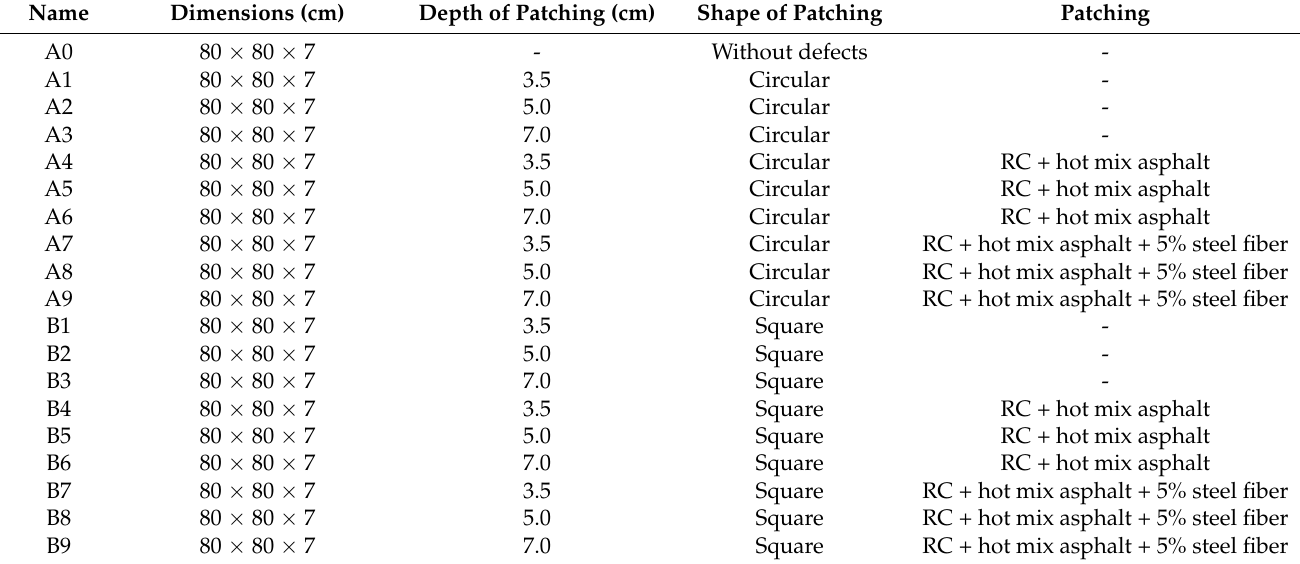
Figure 1. Shape of defects. Table 9. Experimental program carried out on